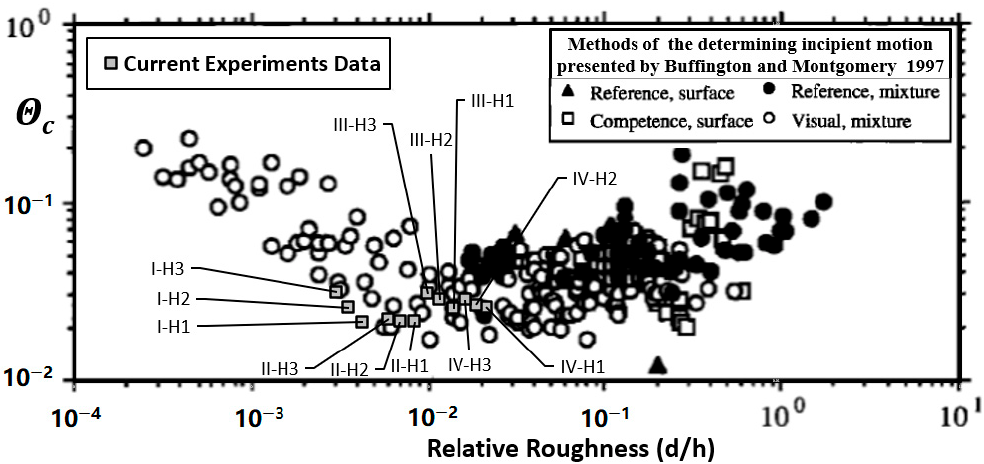
Figure 10. Relation between critical Shields parameter and the relative roughness of the present study, compared to those using different methods for determining the incipient motion presented by Buffington and Montgomery [5].